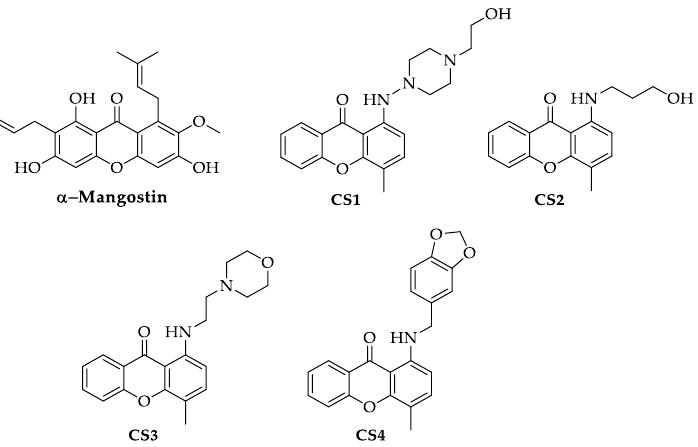
Figure 1. Chemical structures of α -mangostin and four new derivatives of xanthen-9-one.